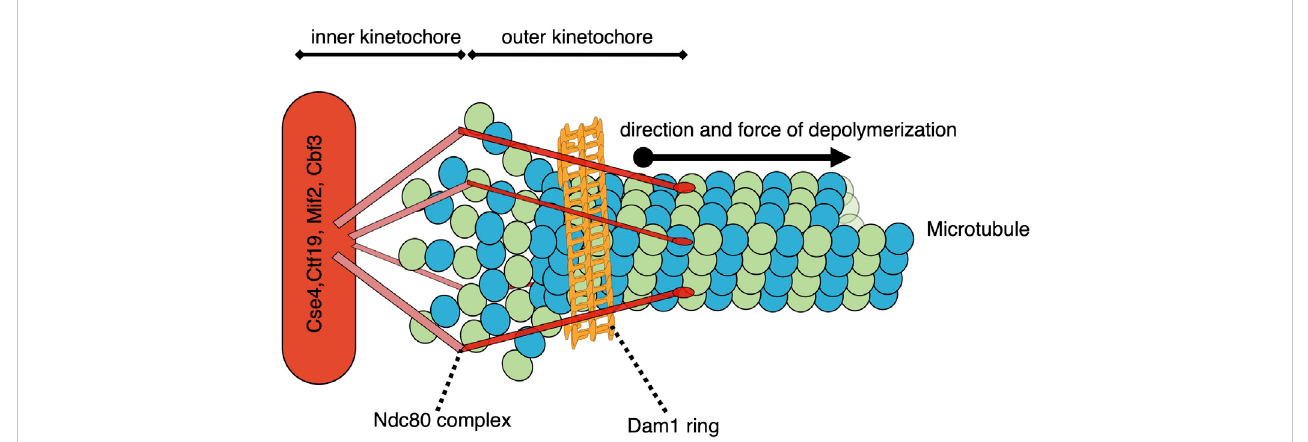
FIGURE 2 Model of a simpli fi ed yeast kinetochore-microtubule attachment with a catch bond-like connection. While many proteins comprise the kinetochore and/orparticipateinthemicrotubule-kinetochoreattachment,twostructuresofnotearetheNdc80complexandtheDam1/DASHcomplexring.Astheend- on microtubule depolymerizes into tubulin heterodimers, the 13 proto fi laments each curve outward. These proto fi laments are constrained within the collar formed by the ring of Dam1/DASH complexes, and their bending drives the collar further onto the depolymerizing microtubule. The Dam1/DASH ring then pulls the associated centromere/kinetochore via the Ndc80-mediated coupling. This pulling force could potentially be sensed by the Dam1/DASH complex, Ndc80, other outer or inner kinetochore proteins, centromere-associated proteins, DNA, or proteins involved in the coupling between the sister